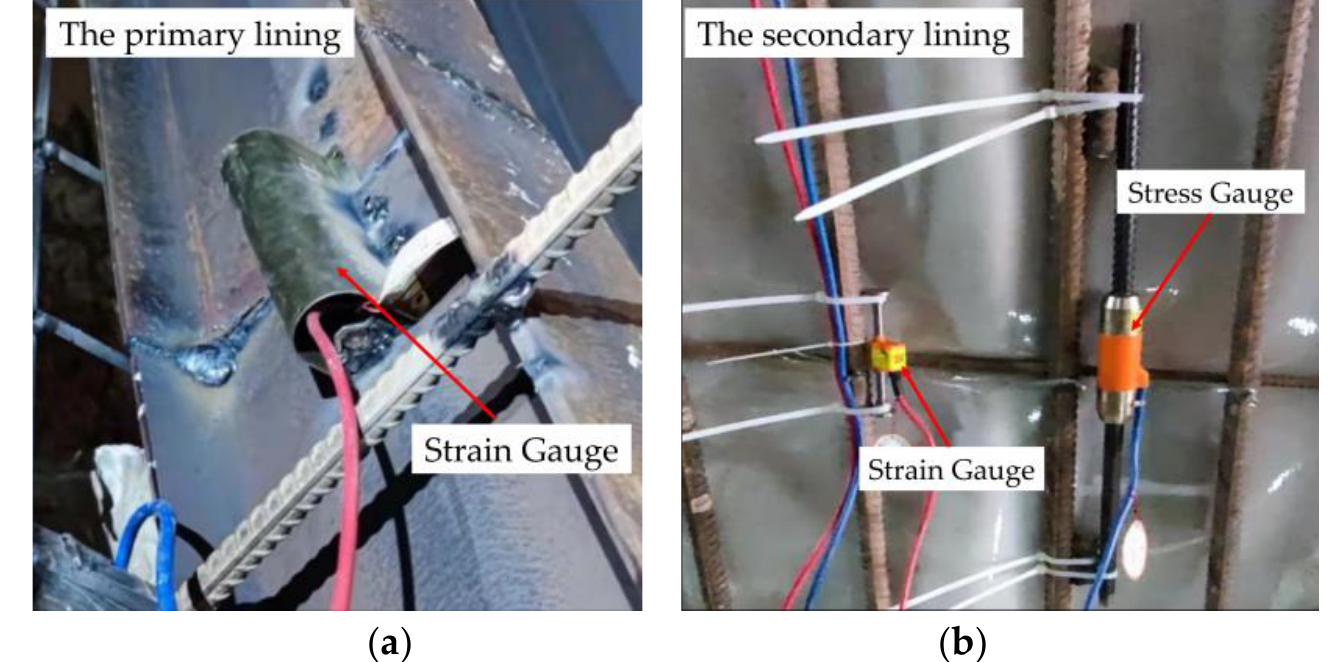
Figure 4. Diagram of field components installation: ( a ) Strain gauge installation in primary lining; ( b ) the strain gauge and stress gauge installation in secondary lining